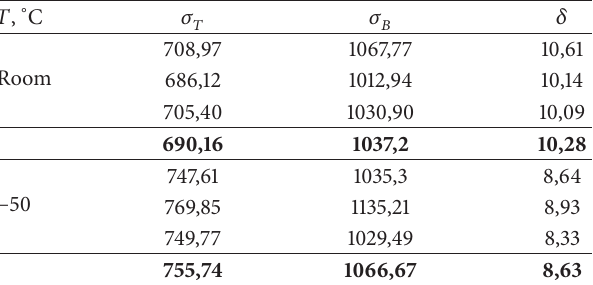
Figure 3: Approximation curve for impact toughness. Table 2: Results of standard tensile